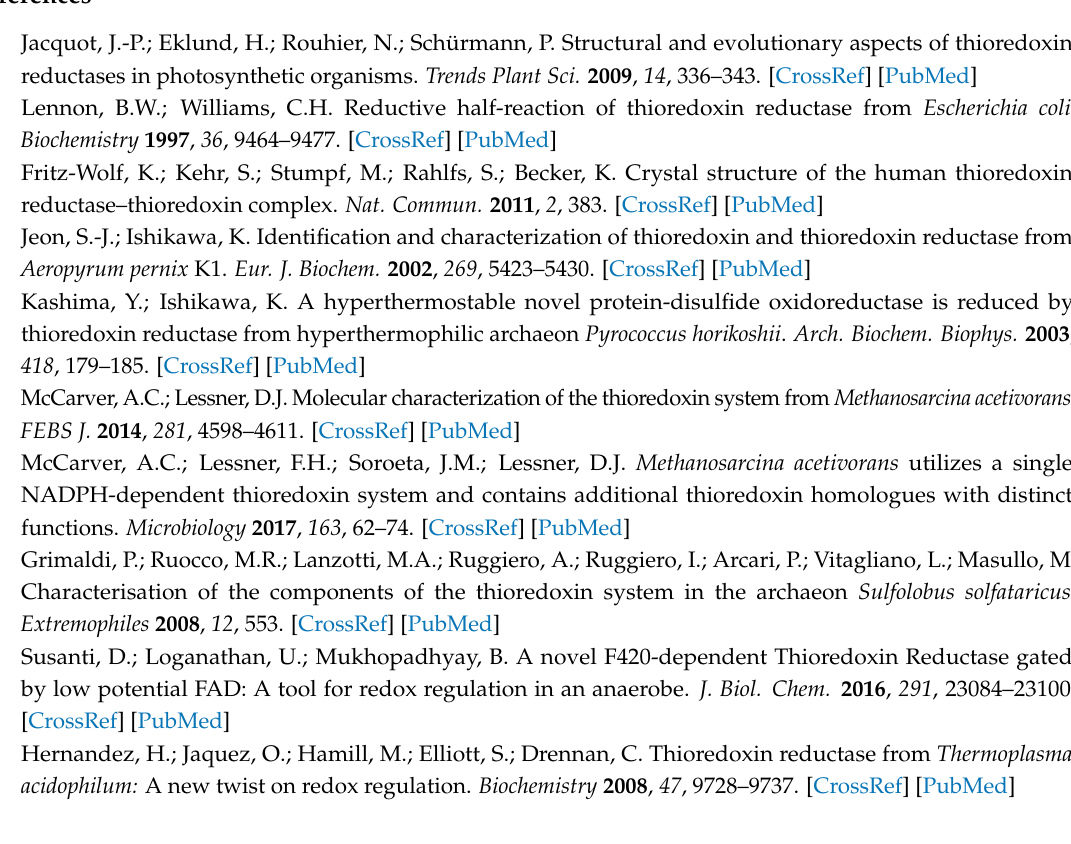
s1, Table S1: Data collection and refinement statistics, Figure S1: Interaction between monomers in MmNTR. The interface is stabilized by hydrophobic interactions, mostly between the side chain of aromatic residues, including Tyr22, Tyr26, Phe161, Tyr301, and Trp264, among others. Hydrogen bonds have also formed